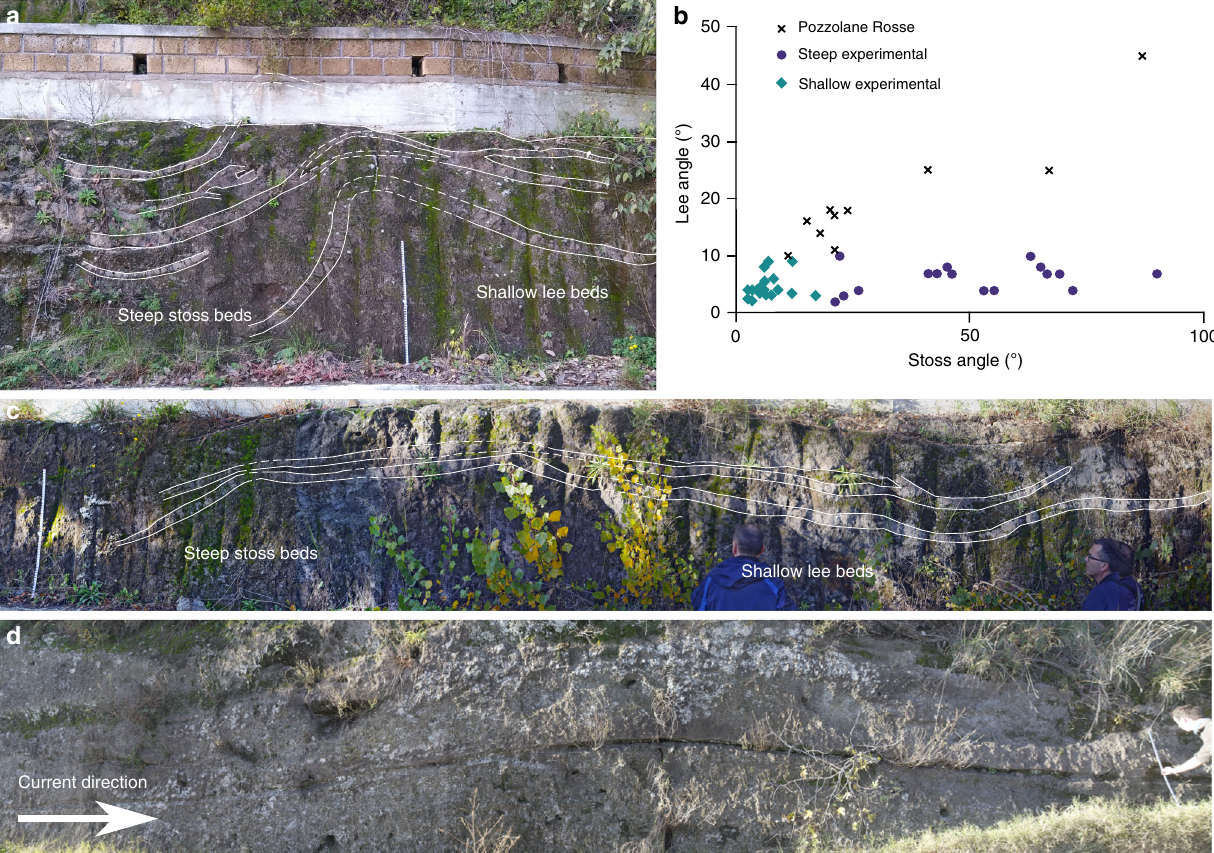
Fig. 6 Field photos and data of the Pozzolane Rosse ignimbrite erupted from Colli Albani, Italy. The ruler is 1 m in length. Coordinates are for UTM 33T grid, using the WGS84 Datum. a steep stoss-side backset bedform at 323348 4639535, c.f. Fig. 2a – c. b Stoss and lee angles for PR and experimental backset bedforms. Several of these backset bedforms have similar stoss angles to our experimental features; however the lee angles are much steeper. c backset bedform directly upstream from a , c.f. Fig. 2d. d Shallow bedform at 323037 4639270, thicker by ~15 cm over the stoss and crest compared with the lee.